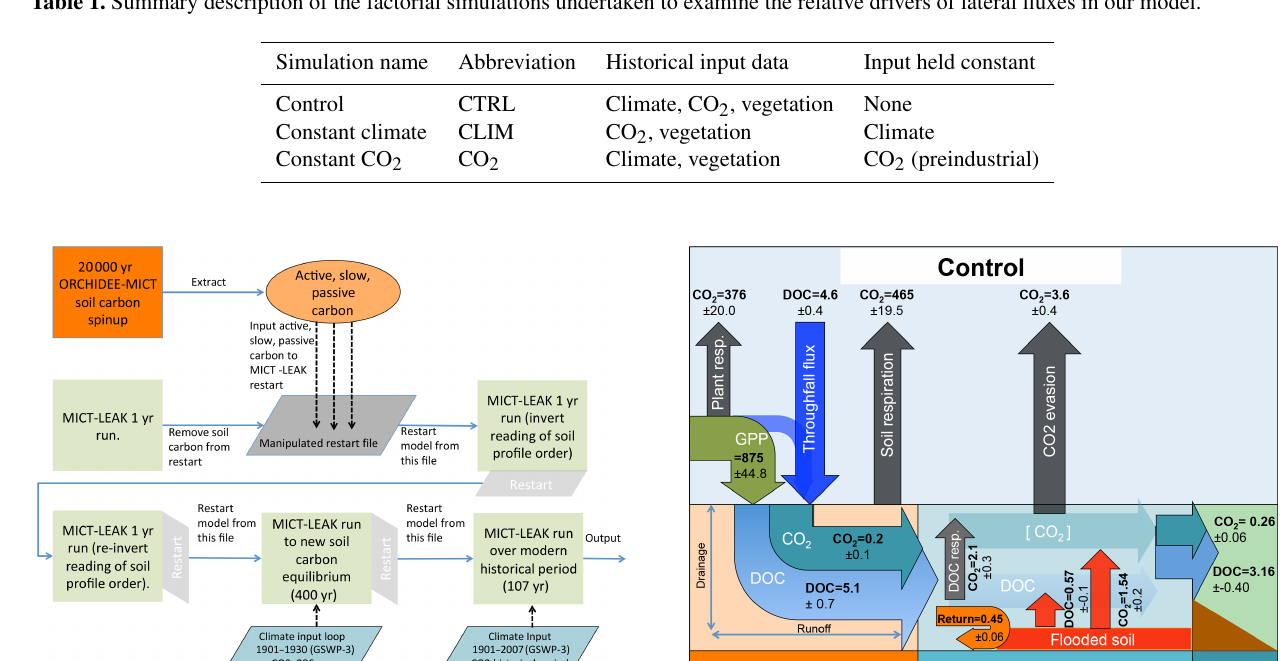
Table 1. Summary description of the factorial simulations undertaken to examine the relative drivers of lateral fluxes in our model.